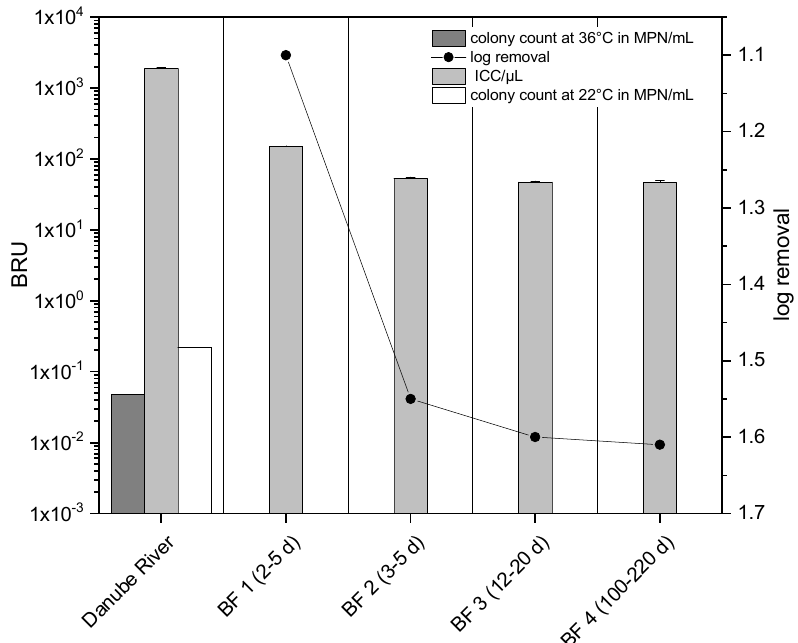
Figure 5. ICC monitored in various RBF wells in Budapest and their travel times in days, BF 1 = Csepel water plant, well No. 1, BF 2 = Tahi 1, well No. 5, BF 3 = Tahi 2 well No. 5, BF 4 = Szigetujfalu, well No. 7 with error bars rep-resenting standard deviation for those points, FCM samples were stained with SYBER® Green and propidiumiodide, HPC data were provided by Budapest Water Works Ltd. Modelled travel times may overlap depending on Danube River water levels.